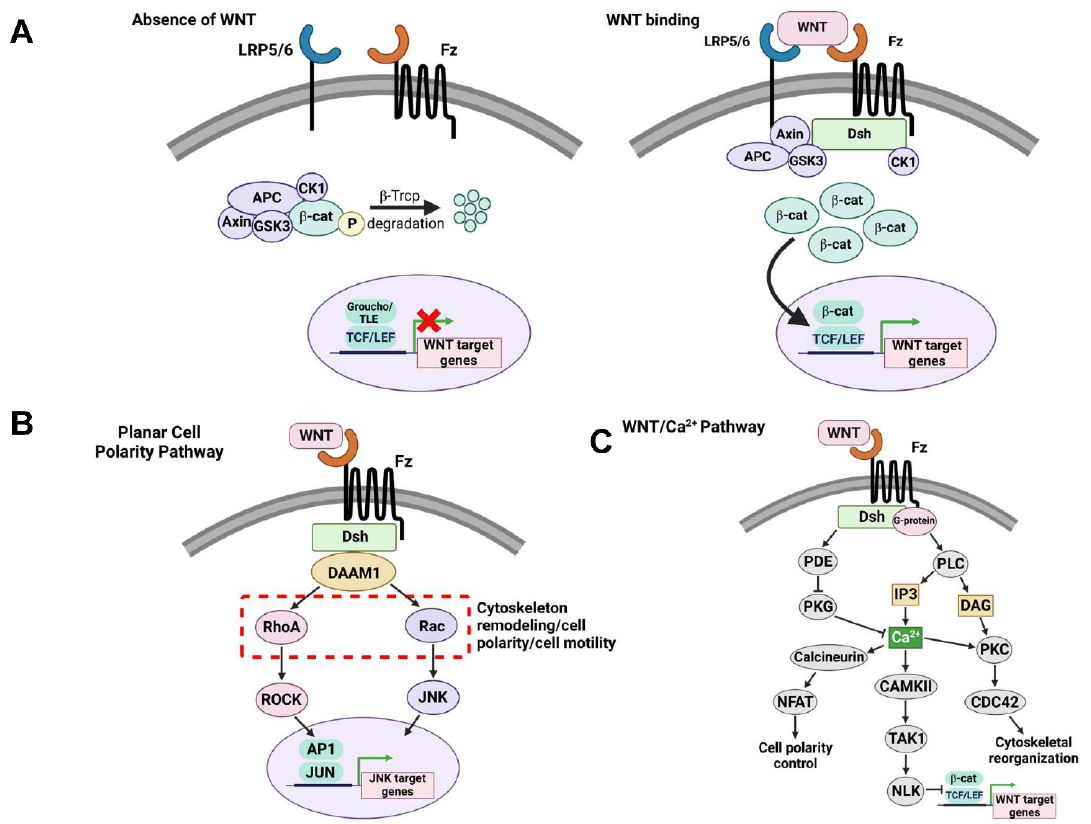
Figure 1. WNT signaling pathways . ( A ) Canonical WNT/ 𝛽 -catenin signaling pathway. Absence of WNT ligand: WNT signaling is in an “o ff ” state when a WNT ligand does not bind to the receptors Frizzled (Fz) and LRP5/6. In turn, the destruction complex (APC, Axin, CK1, GSK-3 𝛽 ) will phos- phorylate cytoplasmic 𝛽 -catenin leading to proteosomal degradation. WNT binding: WNT signaling is turned “on” when a WNT ligand binds to the receptors Fz and LRP5/6. Following binding, the Disheveled (Dsh) sca ff olding protein recruits and complexes with the destruction complex, subse- quently impairing 𝛽 -catenin phosphorylation and degradation. 𝛽 -catenin will accumulate in the cy- toplasm where it will translocate to the nucleus and interact with TCF/LEF factors to regulate tran- scription of WNT target genes. ( B ) Non-canonical WNT/Planar Cell Polarity (PCP) signaling path- way. Activation of WNT/PCP is independent of 𝛽 -catenin and does not require WNT ligand binding to LRP5/6 receptor. After WNT ligand binding, Dsh is activated which then activates RhoA and Rac1, resulting in activation of ROCK and JNK signaling, respectively. Activation of these signaling pathways mediate cytoskeleton remodeling, cell polarity, and cell motility. ( C ) Non-canonical WNT/Ca2+ signaling pathway. WNT ligands bind to Fz inducing the activation and recruitment of Dsh and G-proteins. Here, Dsh activates phosphodiesterase PDE which inhibits PKG and subse- quent release of calcium ions. In addition, Dsh activation induces expression of PLC which functions to activate IP3 and DAG. IP3 promotes the release of calcium ions which activates expression of: Calcineurin and subsequently NFAT leading to greater control of cell polarity, CAMKII which in- duces TAK1 and NLK to repress WNT target gene transcription, and lastly, PKC which promotes CDC42 expression and downstream cytoskeletal rearrangement. 3.1. The Role of WNT Signaling in Neurogenesis Adult neurogenesis can be characterized by the generation of mature neurons from adult neural stem cells [163]. Composed of blood vessels, astrocytes, ependymal cells, and mature neurons, the neurogenic niche maintains the development of neural stem cells